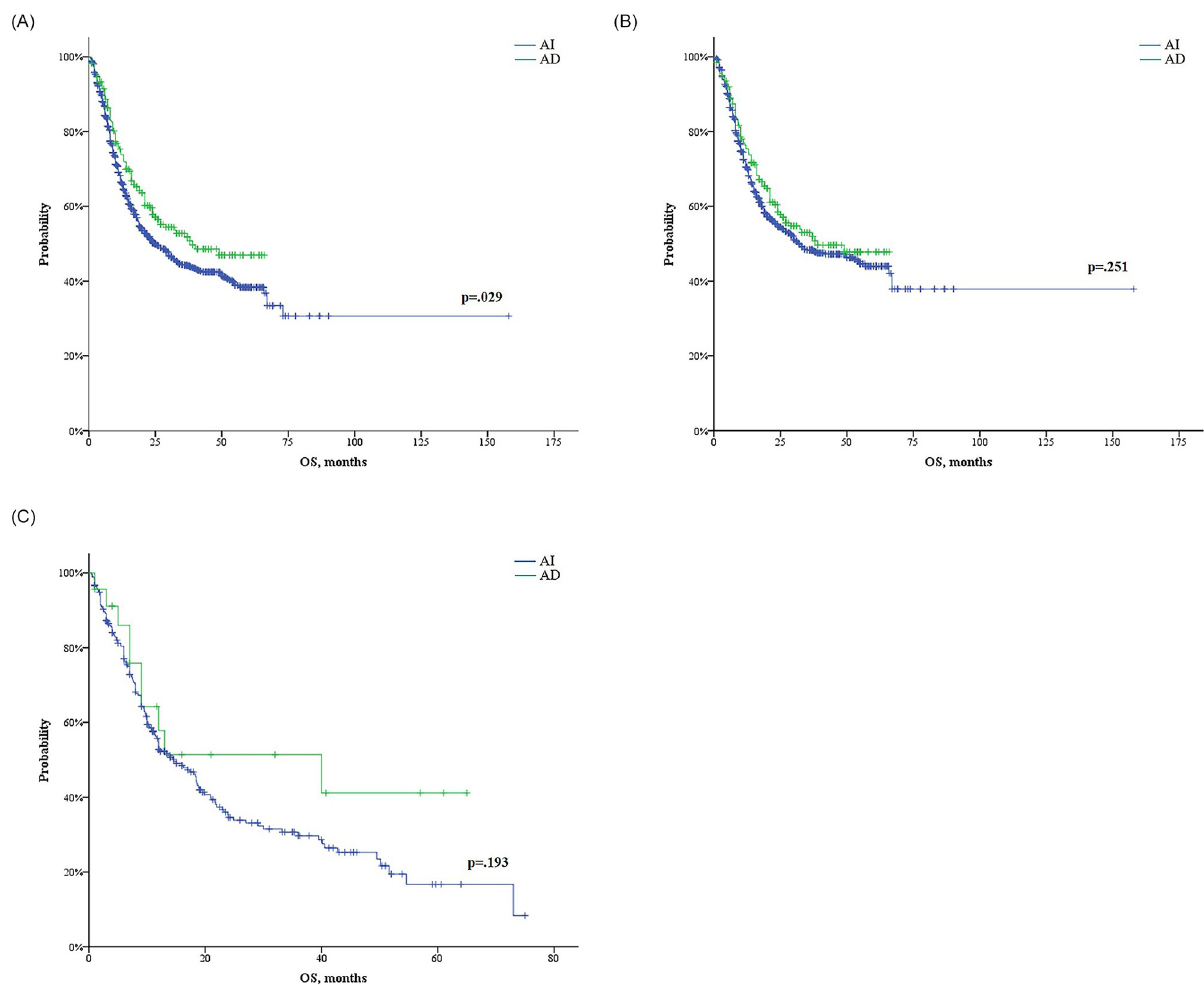
Fig 5. Overall survival (OS) comparison of cytarabine plus idarubicin (n = 1,155) and cytarabine plus daunorubicin (n = 255) in all non–acute promyelocytic leukemia patients (A), those 60 years or younger (B), and those older than 60 years (C).